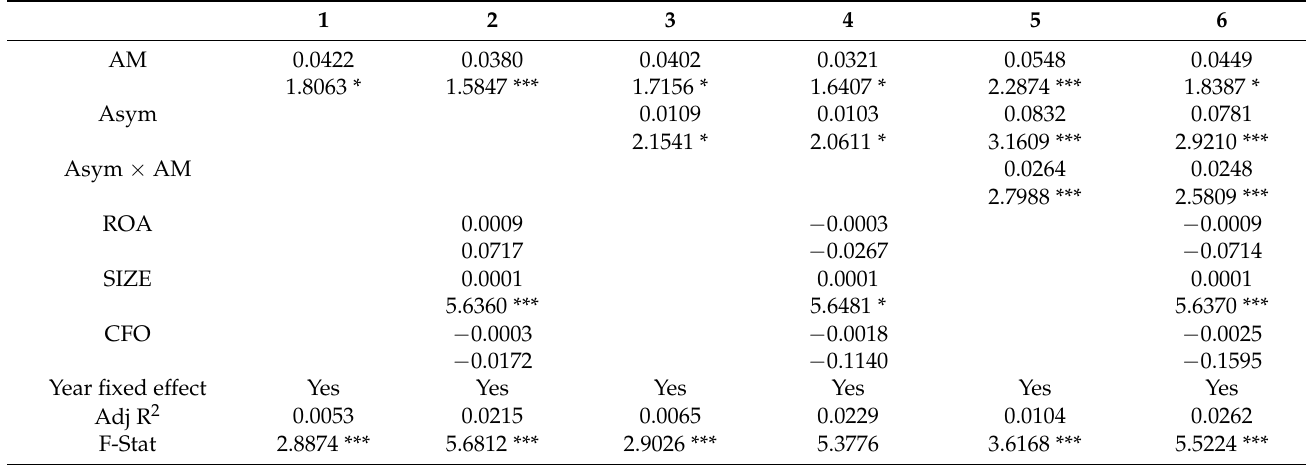
Table 6. The Impact of Negative Accrual Management on Firm-Specific